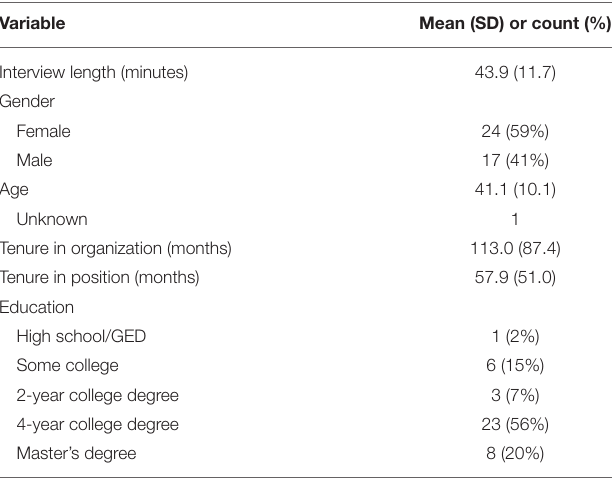
TABLE 1 | Interviewee demographic